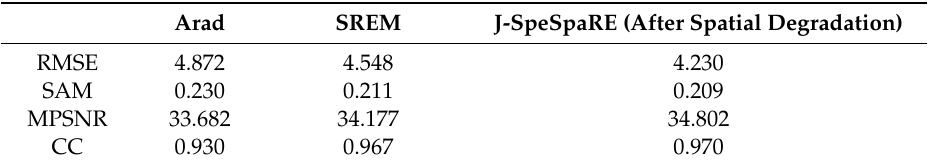
Table 3. Spectral assessment of our proposed method and spectral resolution enhancement methods on Indian pines dataset.